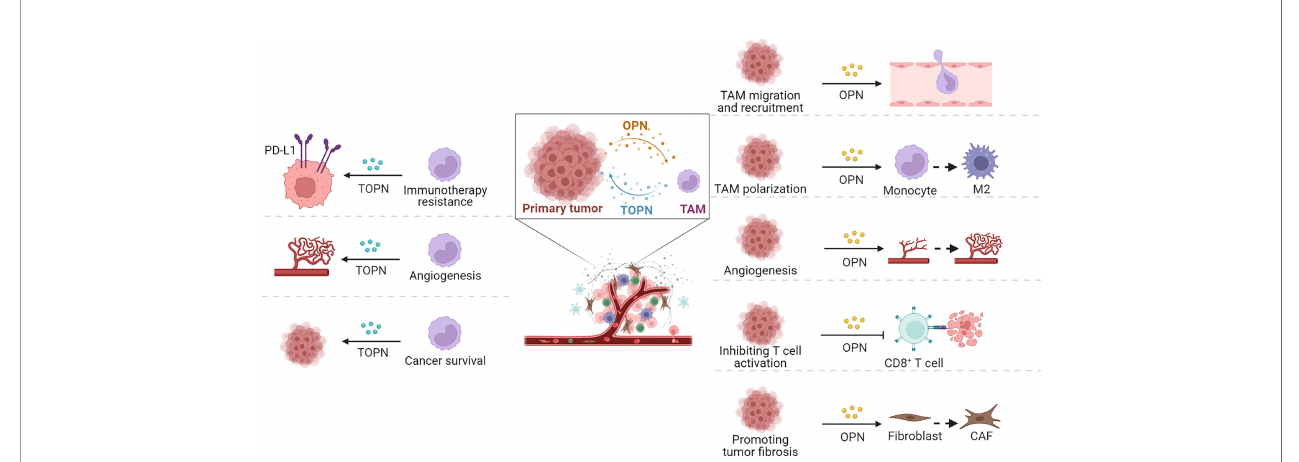
FIGURE 3 | Functions of OPN and TOPN secreted by tumor cells and macrophages separately in TME. OPN played roles in tumor progression through TAMs (right part) and the effect of macrophage-derived OPN, termed TOPN, functioned in tumor tissue summarized (left